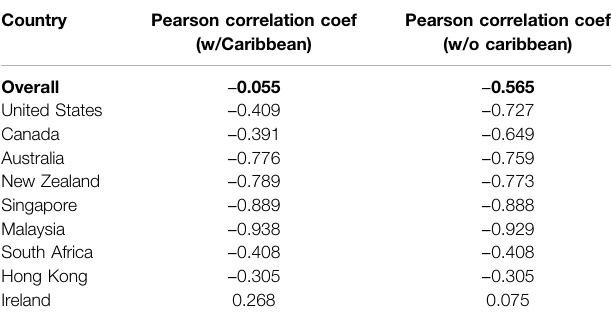
TABLE4| Correlationsbetweenloggeographicdistanceandnumberofcitations. Geographicdistanceismeasuredinkilometresbetweennationalcapitalcities. “ Overall, ” shown in bold, denotes correlation calculated on all country pairs (excludingtheUnitedKingdom).Correlationsforindividualcountriesarecalculated using only the subset of country pairs each country belongs to. Larger negative values indicate stronger negative correlations between distance and citation count. Pearson correlation coef (w/Caribbean)